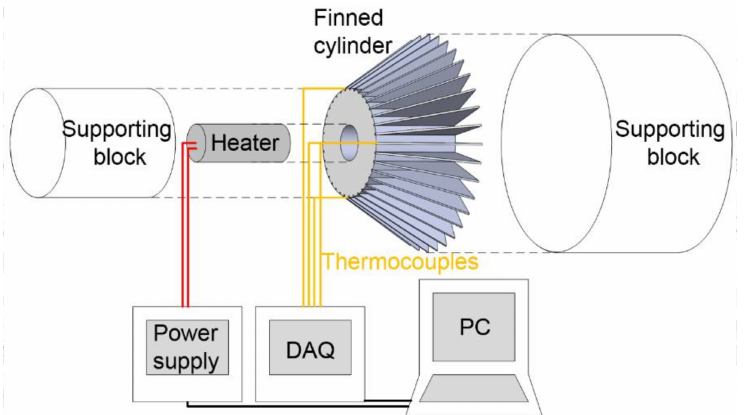
Figure 3. Schematic diagram of experimental